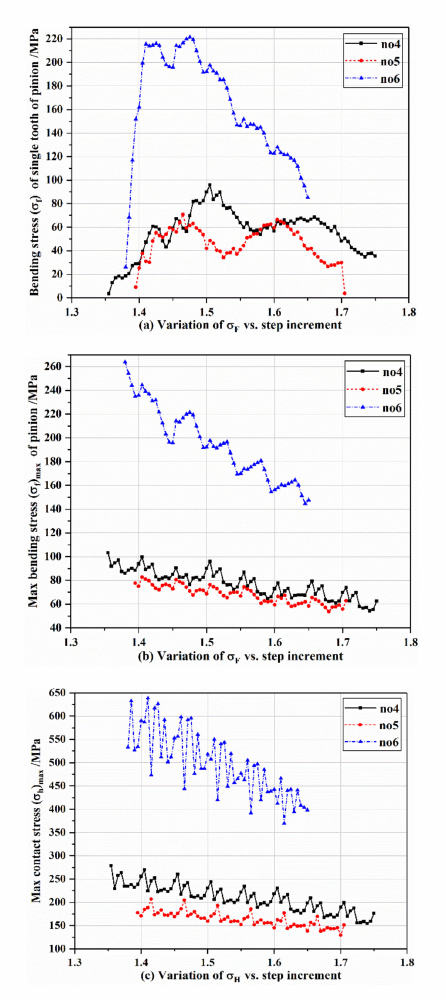
Figure 13. Influence of modification angle on bending and contact stresses. ( a ) Bending stress of single tooth of pinion; ( b ) maximum bending stress of pinion; ( c ) maximum contact stress of